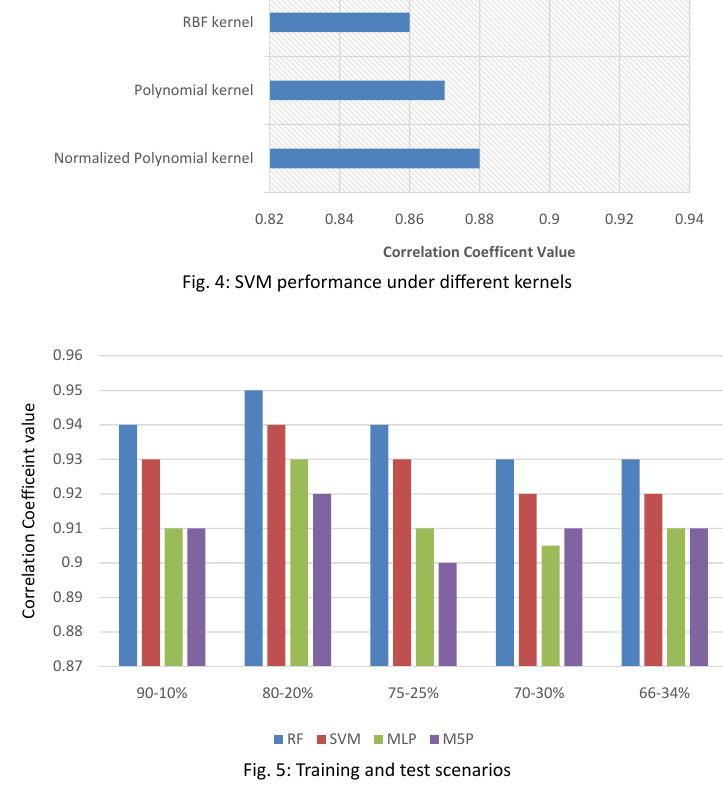
Fig. 6: Training and test scenarios Fig. 5: Training and test